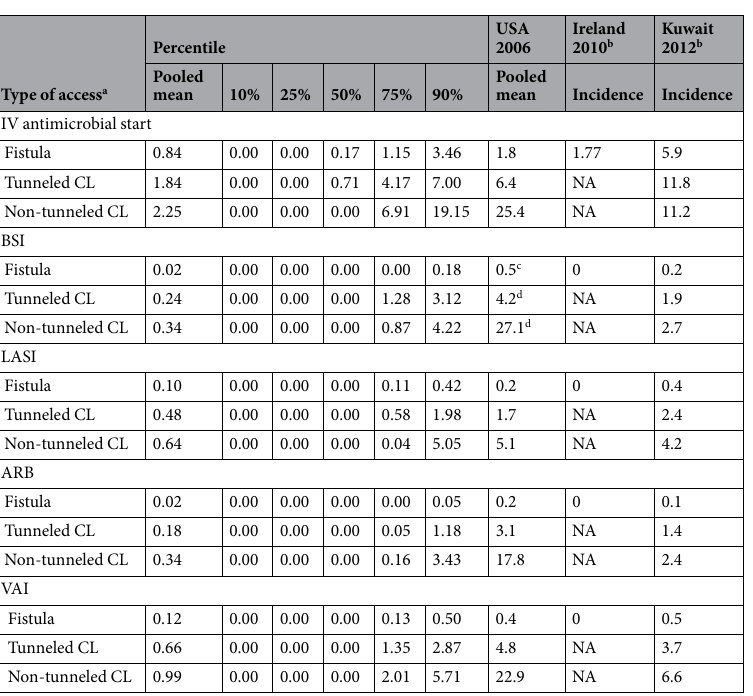
soft tissue infection (n = 31), gastrointestinal infection (n = 30), and eye, ear, nose, throat, or mouth infection (n = 25). Discussion